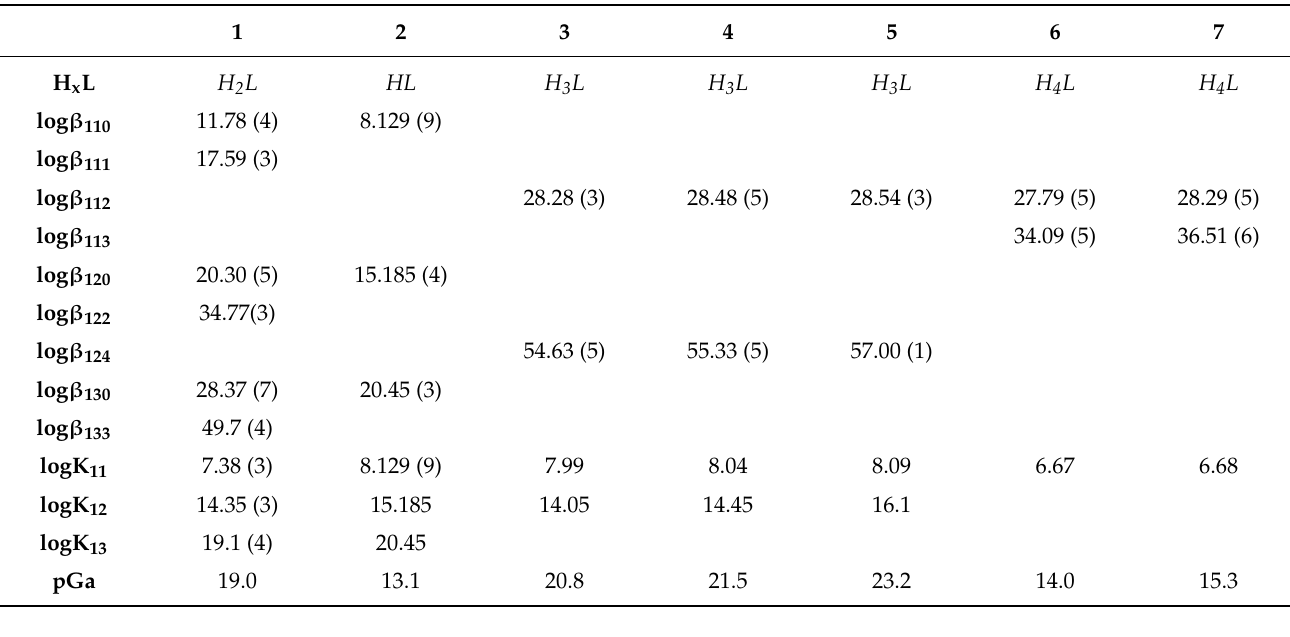
The species distribution curves for 1 , 4 and 7 are reported in Figure 11.